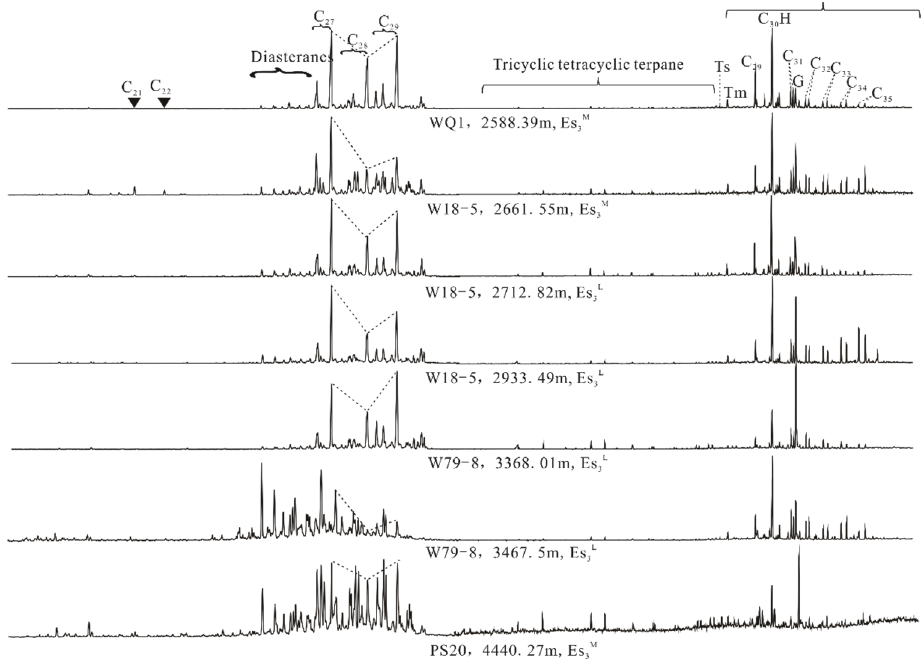
Figure 5. Mass chromatograms of m / z 217 and m / z 191 of the source rocks in the Dongpu Depression.